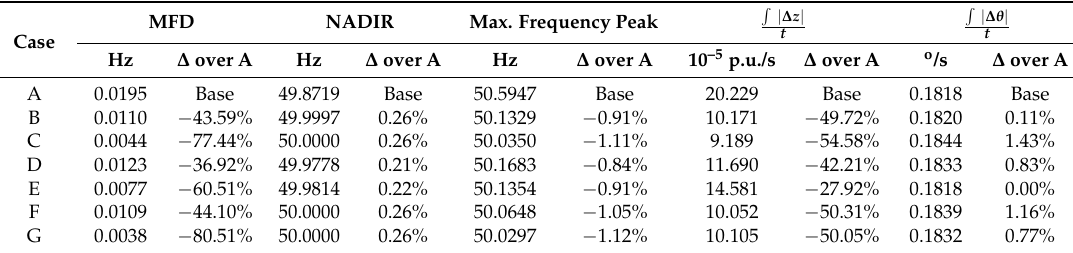
Table 5. Simulation results with a ramp wind speed.